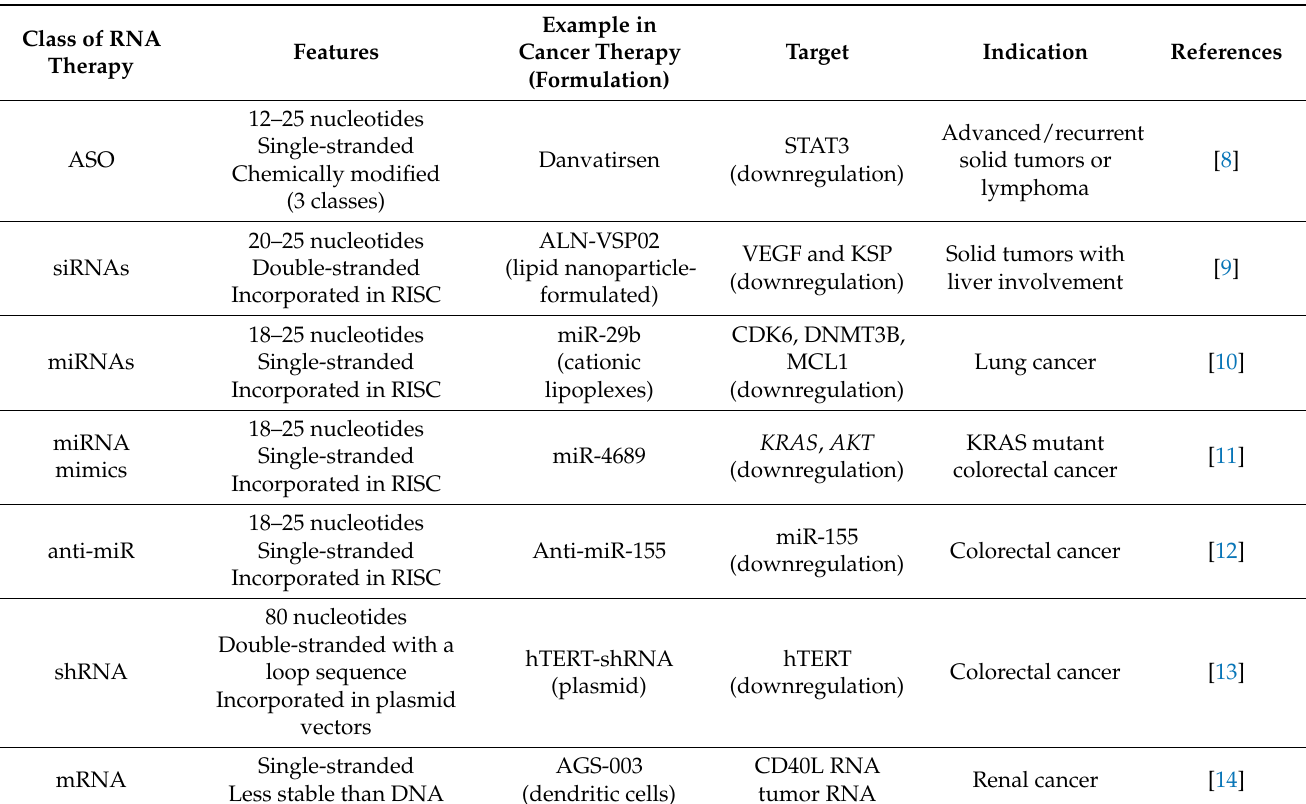
Table 1. Main classes of RNA